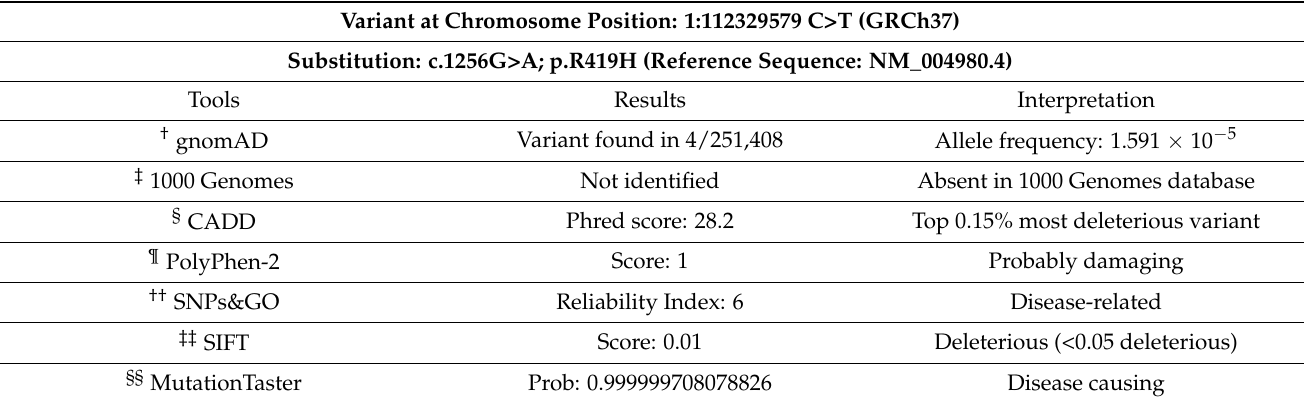
Table 1. Bioinformatics analyses of the KCND3